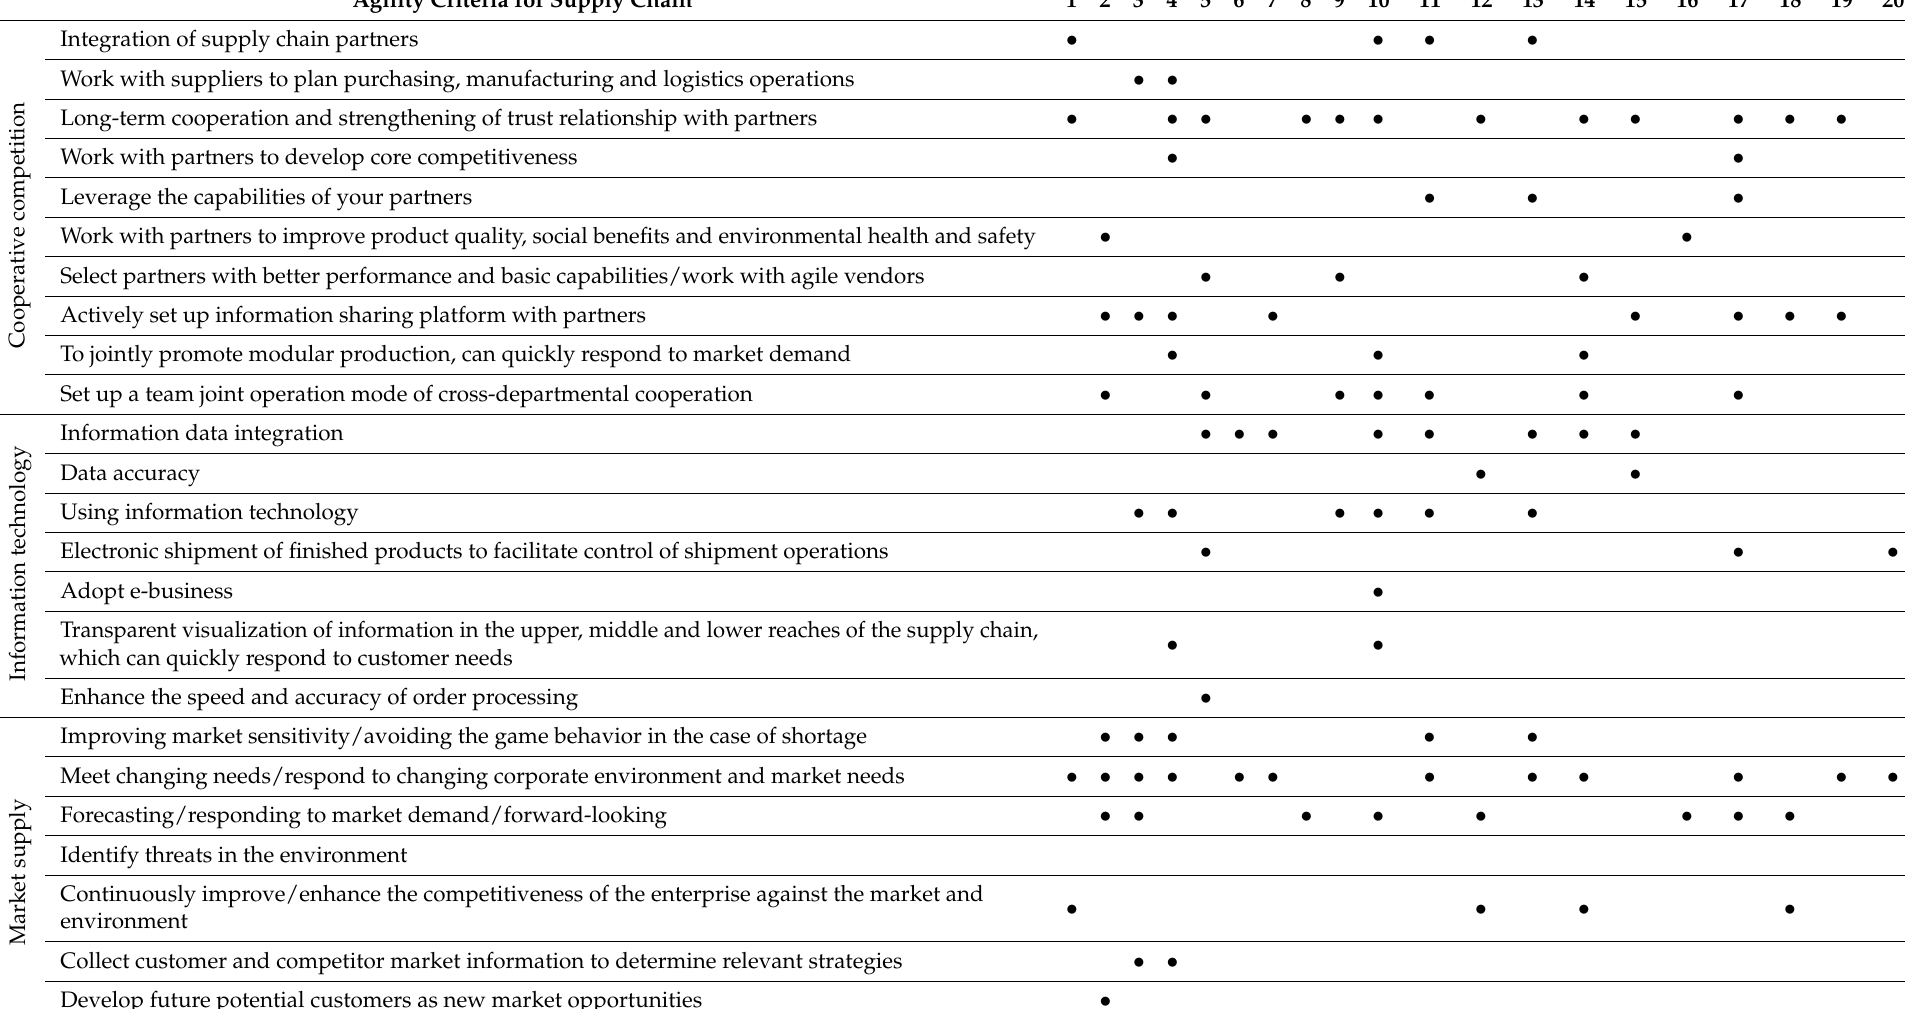
Table A2. Proposed agility criteria for supply chain by scholars. Agility Criteria for Supply